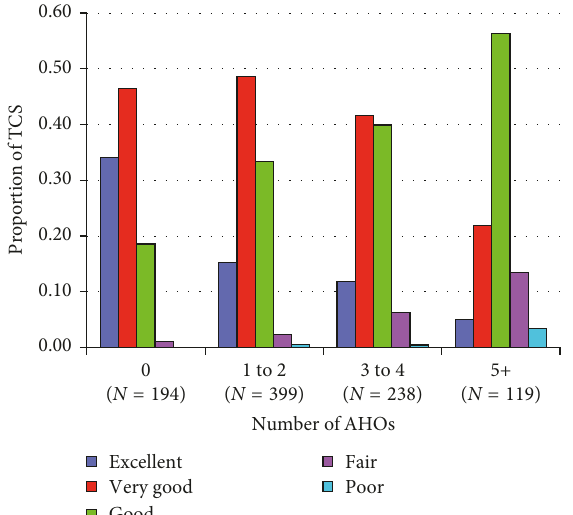
0.01 (Mantel 1 df chi-square Adapted with < ∗